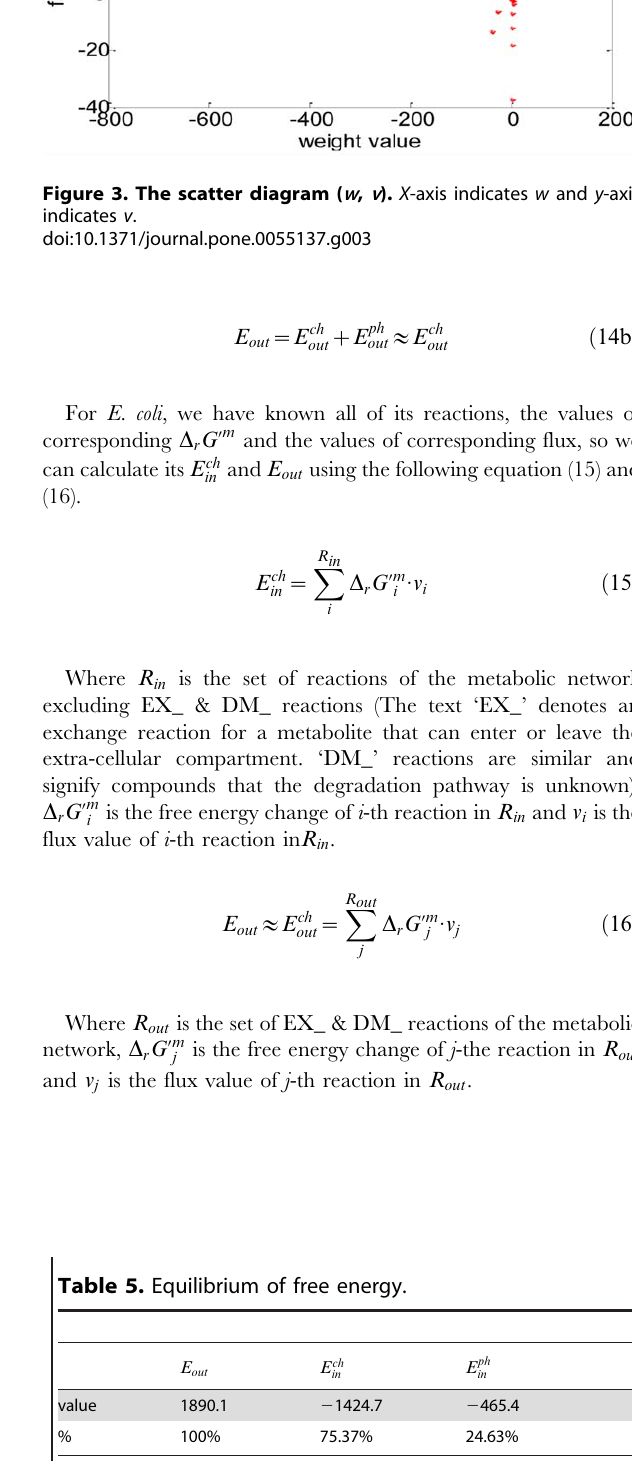
Figure 3. The scatter diagram ( w , v ). X -axis indicates w and y -axis indicates v .